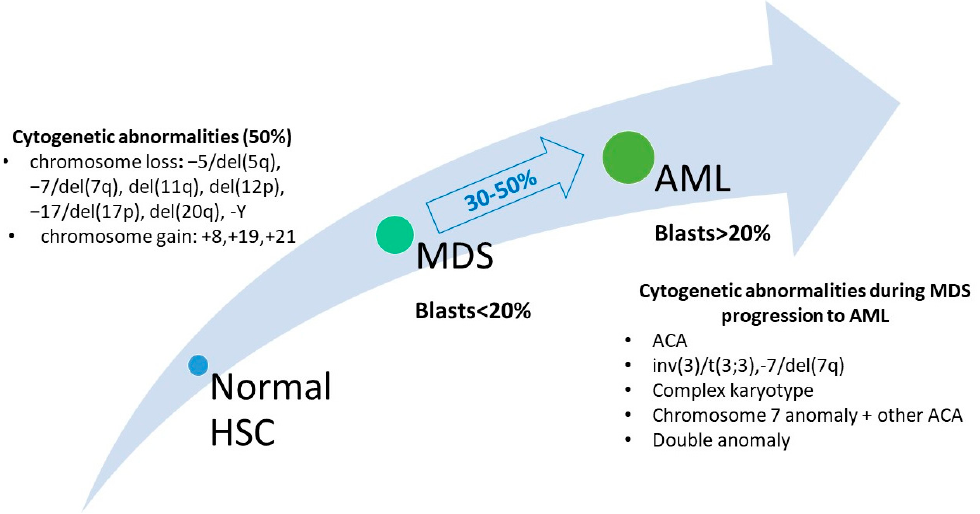
Figure 2. Chromosomal aberrations in MDS and in MDS progression to AML (HSC—hematopoietic stem cell; ACA—additional chromosomal abnormalities; del—deletion; inv—Inversion, t—translo- cation).